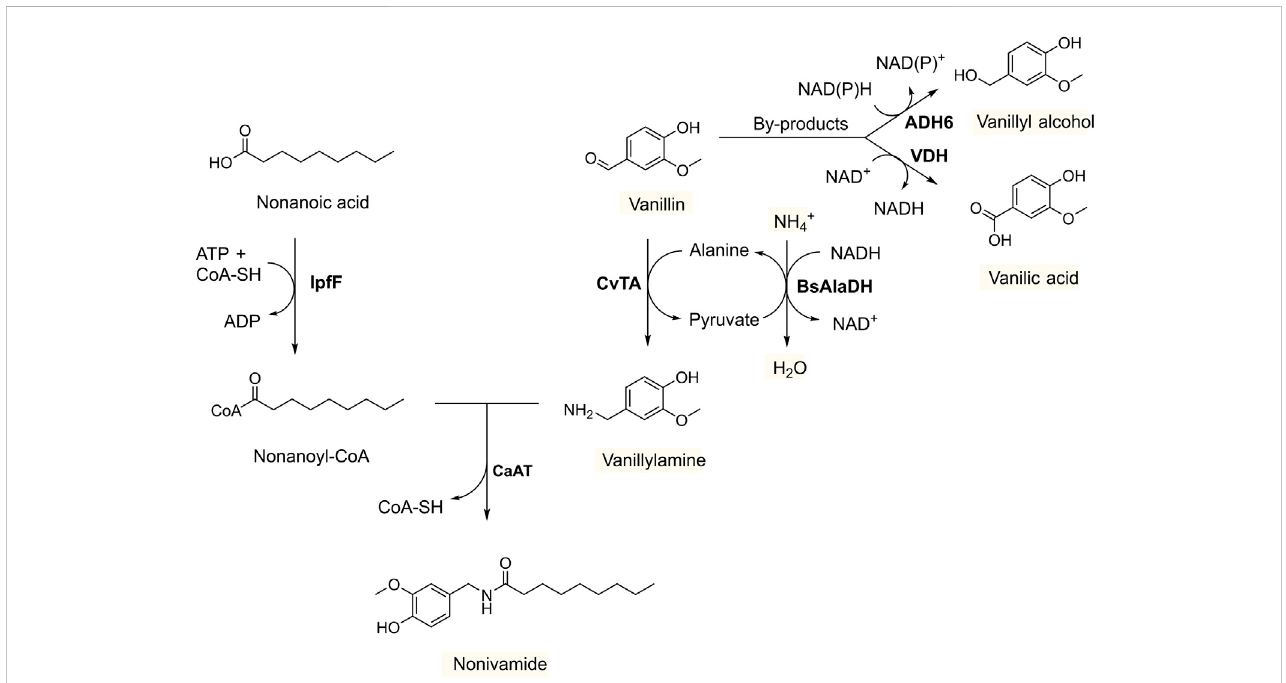
FIGURE 1 Production of nonivamide from non-anoic acid and vanillin in recombinant yeast overexpressing IpfF ( Spingomonas sp. Ibu-2 CoA-ligase), CaAT ( Capsicum annuum N -acyltransferase), CvTA ( Chromobacterium violaceum amine transaminase) and BsAlaDH ( Bacillus subtilis alanine dehydrogenase), and with deleted ADH6 (alcohol dehydrogenase 6). The by-products vanillyl acid and vanillic alcohol formed by endogenous enzymes VDH (vanillin dehydrogenase),andADH6(andotheroxidoreductases),respectively,aresuppressedunderoxygen-limitedconditionsandwithethanolasco-substrate to regenerate